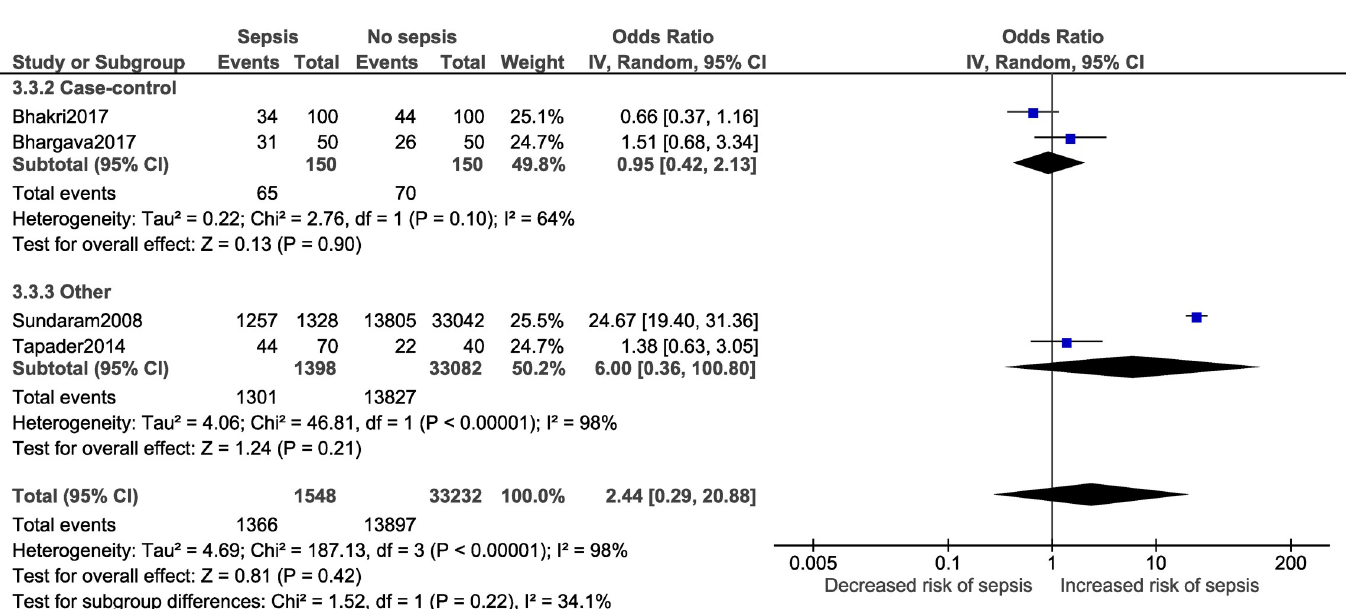
PLOS ONE | https://doi.org/10.1371/journal.pone.0215683 April 25, 2019 12 /